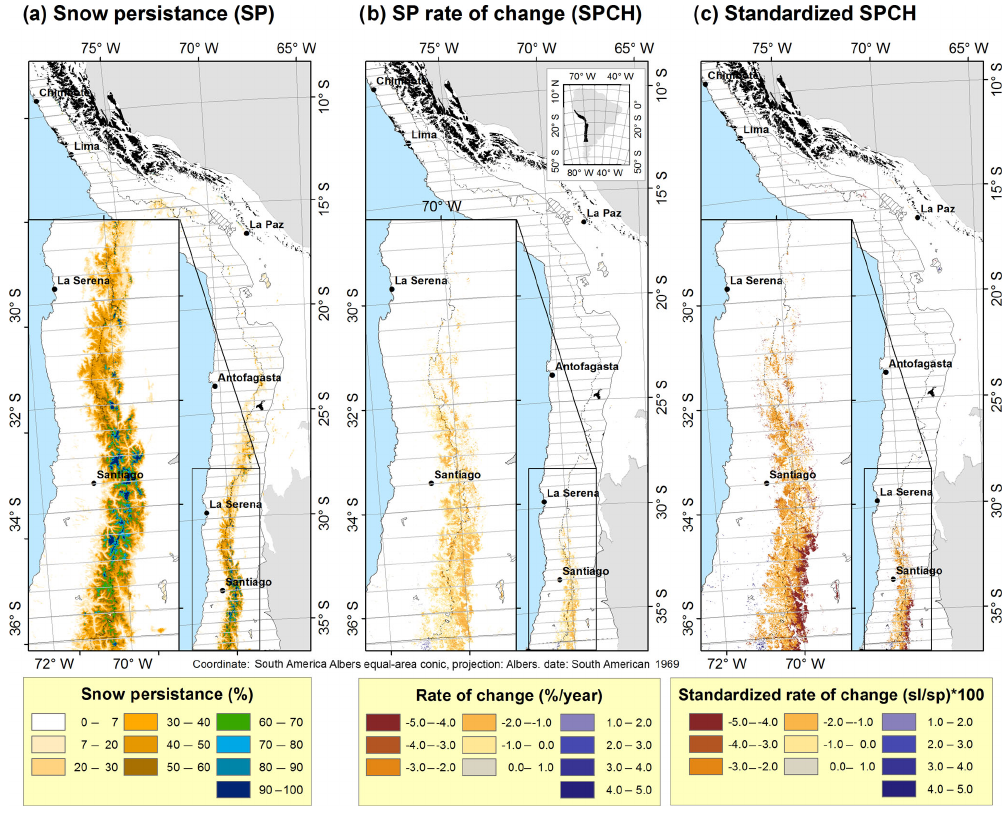
Figure 3. Spatial patterns of (a) snow persistence (SP) 2000–2016, (b) rate of change (Theil–Sen slope) in annual SP 2000–2016, and (c) standardized rate of change (Theil–Sen slope/SP); pixels are only colored in panels (b) and (c) , where the trend is significant at p ≤ 0.05. All images exclude areas with little to no snow (mean annual SP ≤ 7%). Areas with frequency of cloud greater that 30% are masked in